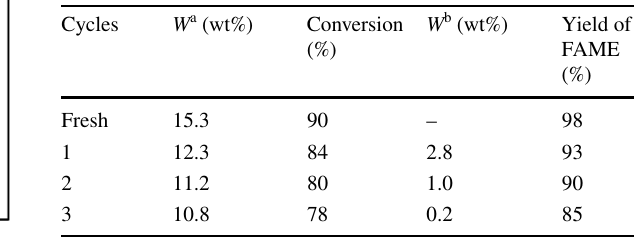
Table 2 Recyclability of 20% HPWA/KIT-6